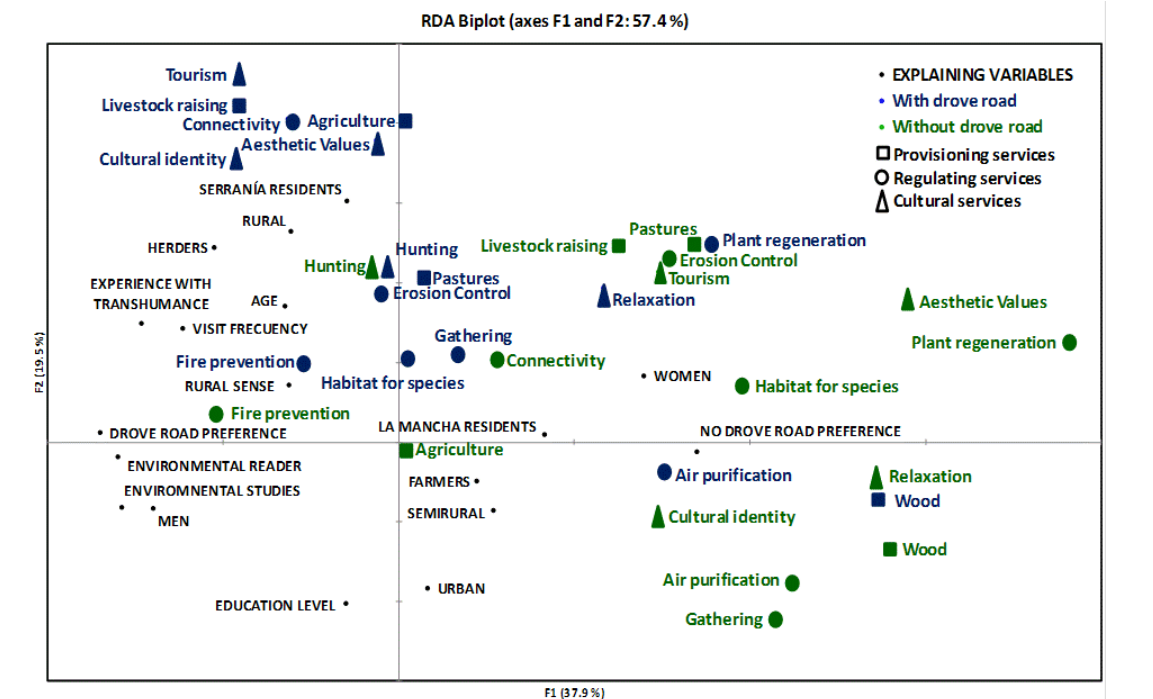
Fig. 3 . Biplot resulting from RDA (redundancy analysis) factors 1 (37.9% of variance explained) and 2 (19.5% of variance) for ecosystem services public appreciation in the pair of photographs depicting the La Mancha cropland. Ecosystems services suggested for landscape picture with a drove road (Fig. 1D) are presented in blue, while the ecosystems services suggested for the landscape picture without a drove road (Fig. 1C) are presented in green. The ovals indicate the four groups of respondents